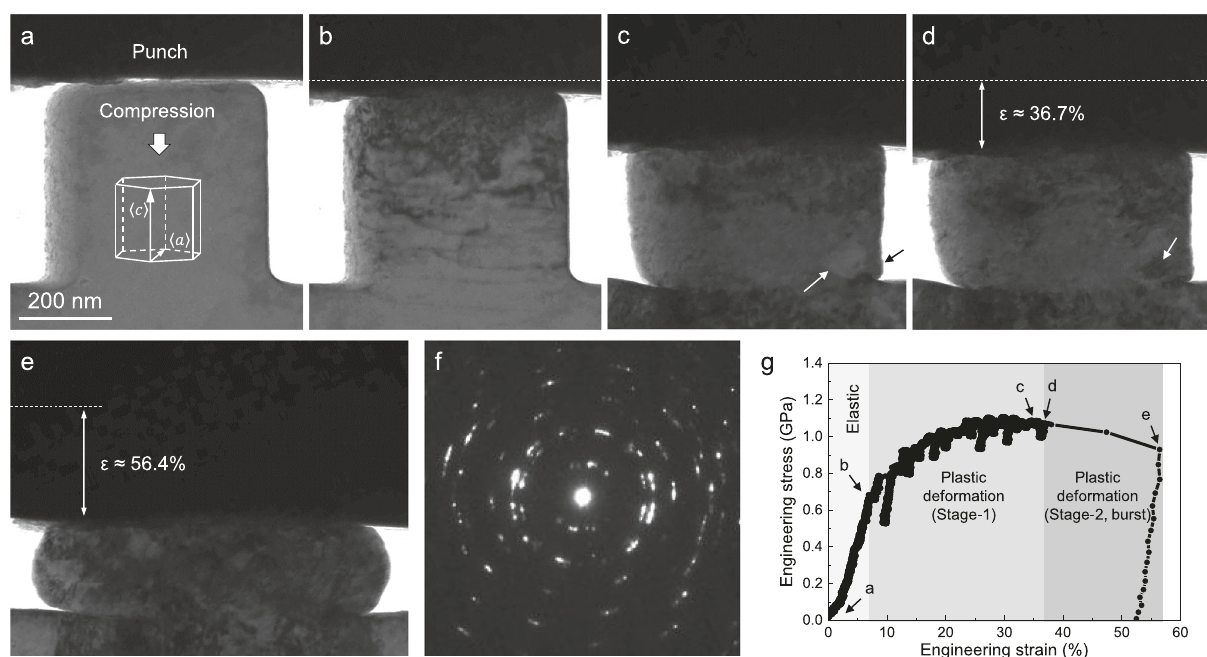
Fig. 1 A submicron Mg single crystal pillar uniformly deformed under c -axis compression, then fl attened in a strain burst. a The initial pillar before compression. Inset hexagonal unit cell shows the loading orientation. Viewing direction, (cid:2)h 2 (cid:1) 1 (cid:1) 10 i . b Formation and motion of dislocations. c A new grain formed in the lower right corner of the pillar (white arrow). d Dark contrast emerged in the new grain suggesting dislocation or twinning activity inside. e The pillar suddenly fl attened. f Selected area diffraction patterns acquired from the fl attened sample. g Corresponding stress-strain curve showing the two-stage plastic